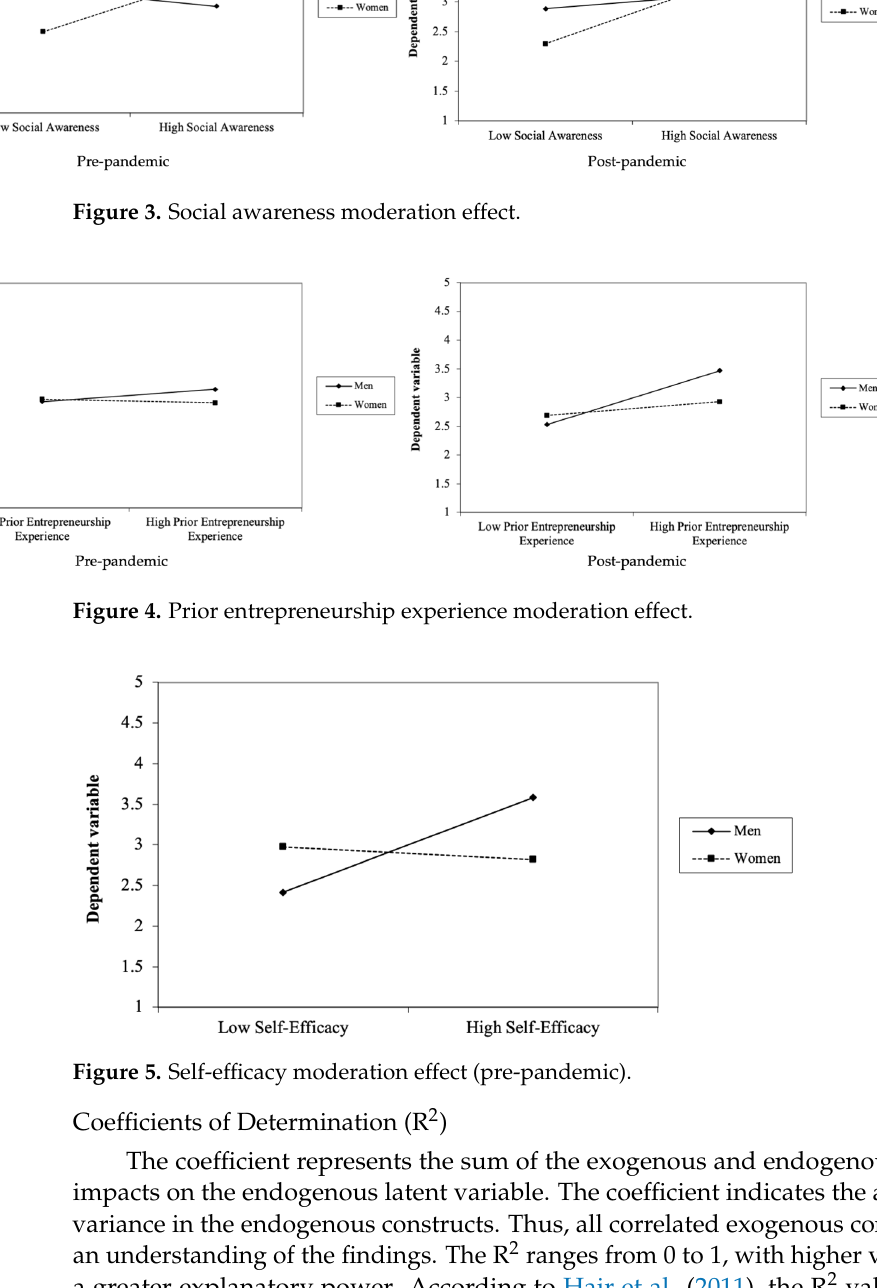
Table 11. Coefficients of determination (R 2 ) .